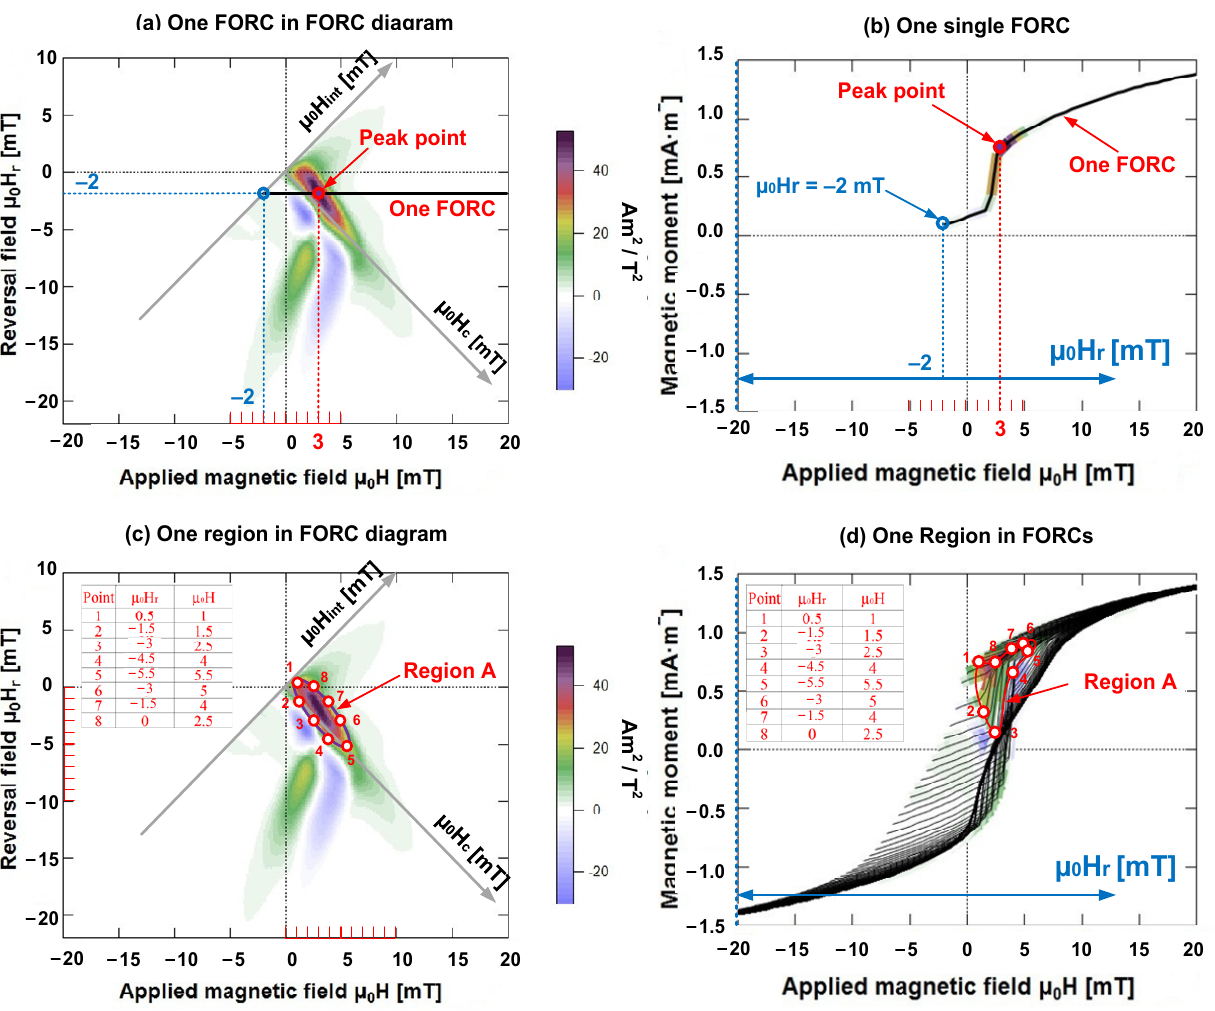
Figure 5. FORC diagram and FORCs. ( a , b ) FORC curve corresponds to the horizontal line in FORC diagram. ( c , d ) Several FORCs corresponding to a region in the FORC diagram.